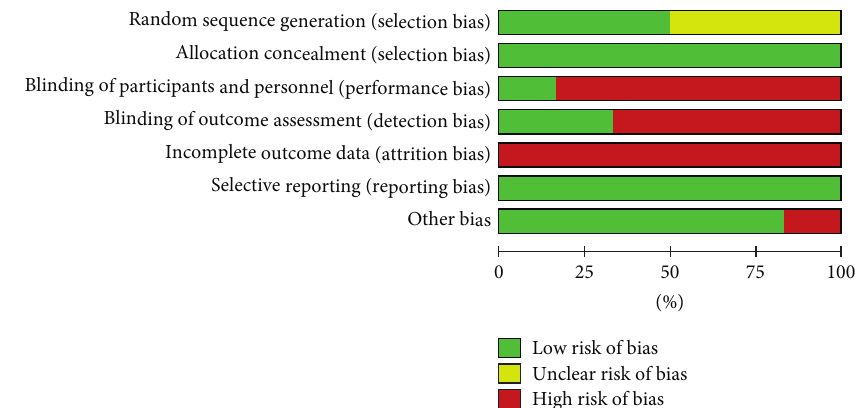
Figure 3: Risk of bias graph with overall percentages of bias for each domain.